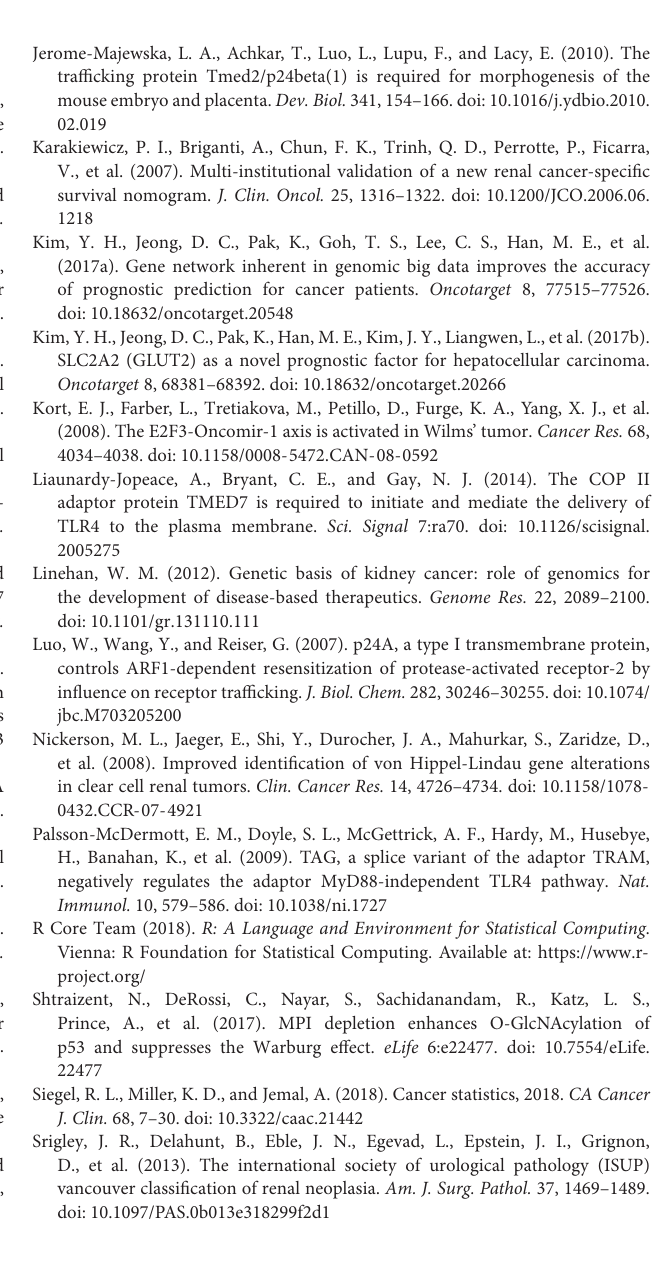
FIGURE S1 | Comparison of TMED3 gene expression according to T stages in the TCGA (A) and ICGC (B) ccRCC cohorts. FIGURE S2 | Comparison of TMED3 gene expression between cancer and normal kidney in GSE11024 (A) , GSE12606 (B) , and GSE14762 (C)